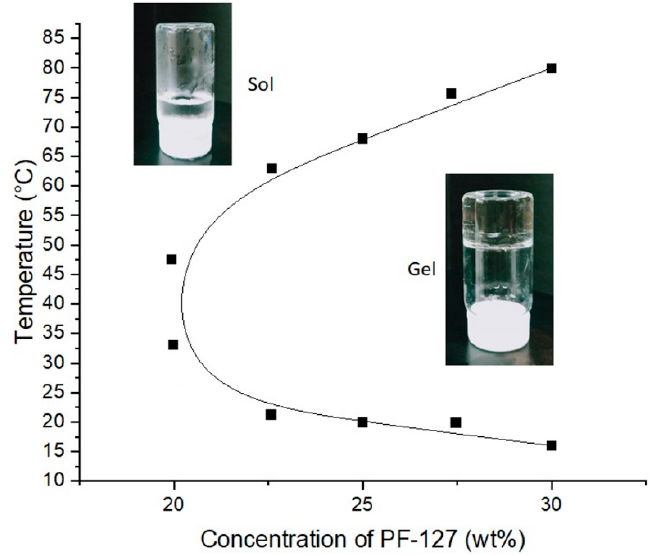
Figure 5. Phase diagram of PF127 at different concentrations and temperatures.